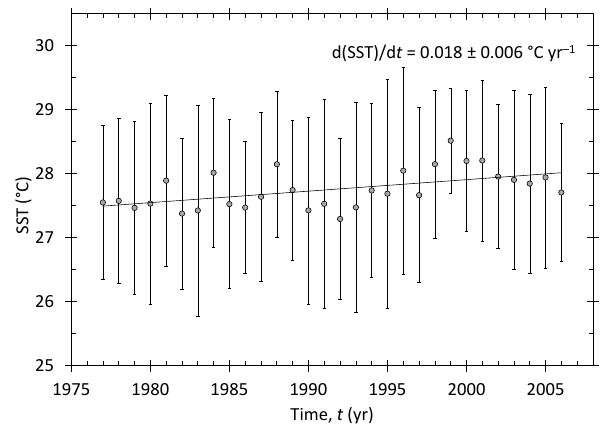
Fig. 4. NCEP monthly reanalysis data (Kalnay et al., 1996; NOAA, 2010) for Sea Surface Temperature (SST) for the region surround- ing Mauna Loa, 18.1–21.9 ◦ N and 153.8–157.5 ◦ W, 1977–2006. Circles represent the mean of the monthly SST values for a given year, with error bars ± 1 standard deviation of the 12 monthly SST values. The best-fit line using ordinary least-squares is shown (solid line), with slope d(SST)/d t =0.018 ± 0.006 ◦ Cyr − 1 (uncer- tainties ± 1s.e. of the